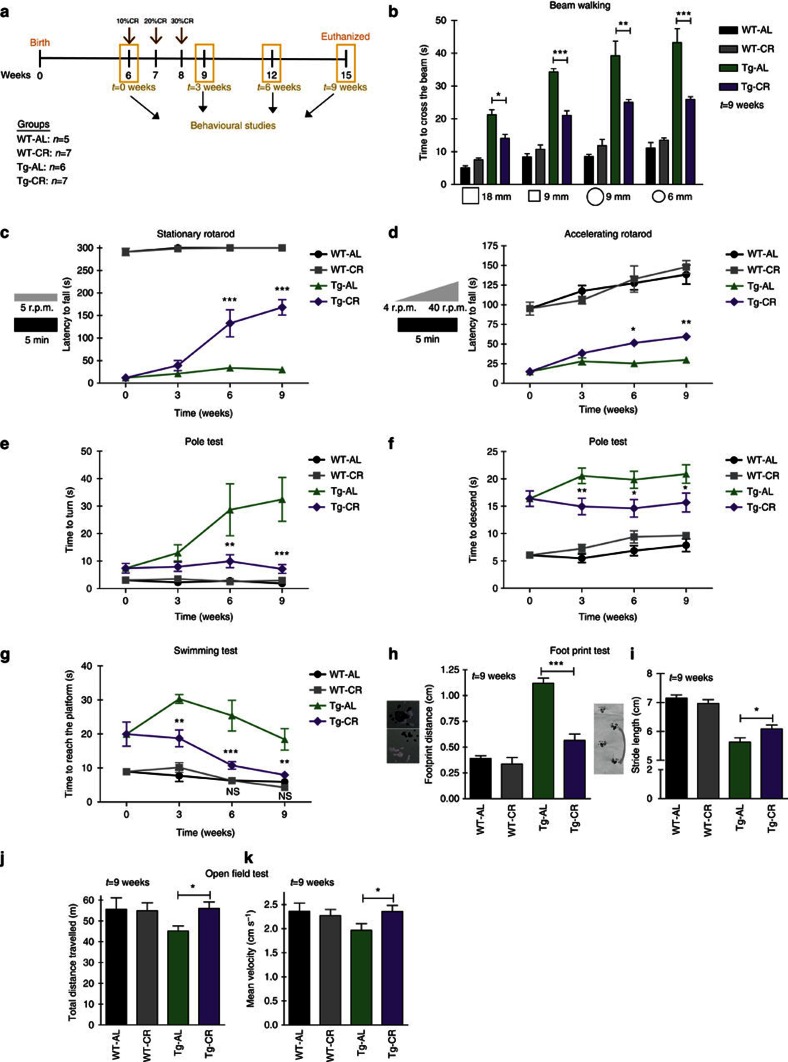
CR alleviates balance and motor coordination impairments and ameliorates gait and locomotor activity in a Tg MJD mouse model.(a) Representative study design; 6-week-old Tg and WT littermate mice were divided in two groups: AL group (AL) and calorie-restricted group (CR). Every 3 weeks, behavioural tests were performed, until animals were 15 weeks old. (b) Beam walking test demonstrating an amelioration of the motor performance of calorie-restricted mice, 9 weeks after the beginning of CR diet. (c,d) Tg MJD mice in CR diet had better performance in constant velocity (5 r.p.m.) and accelerated (from 4 to 40 r.p.m.) rotarod, compared with Tg MJD AL mice. (e,f) Vertical pole test. Since the sixth week, calorie-restricted Tg MJD mice turned downwards easier than the Tg mice in the AL diet (e) and descended the beam with less difficulties (f). (g) Swimming test performance. Since the sixth week, Tg mice exhibited a rescue of the common improper performance in the swimming pool. (h,i) Quantitative analysis of the footprint patterns. Calorie-restricted mice had a higher stride length and a more perfect footprint overlap and their performance is significantly closer to WT performance, 9 weeks after the beginning of CR diet. (j,k) Open-field test. Calorie-restricted Tg MJD mice travelled the same distance and with the same mean velocity than WT mice. Calorie-restricted mice had a higher stride length and a more perfect footprint overlap, and their performance is significantly closer to WT performance, 9 weeks after the beginning of CR diet. Data represent mean±s.e.m.; NS P>0.05, *P<0.05, **P<0.01 and ***P<0.001 compared with Tg-AL. (b–g) Two-way analysis of variance (ANOVA) with Bonferroni's post-hoc test. (h–k) One-way ANOVA with Bonferroni's post-hoc test. WT-AL n=5; WT-CR n=7; Tg-AL n=6; Tg-CR n=7. See also Supplementary Fig. 1.